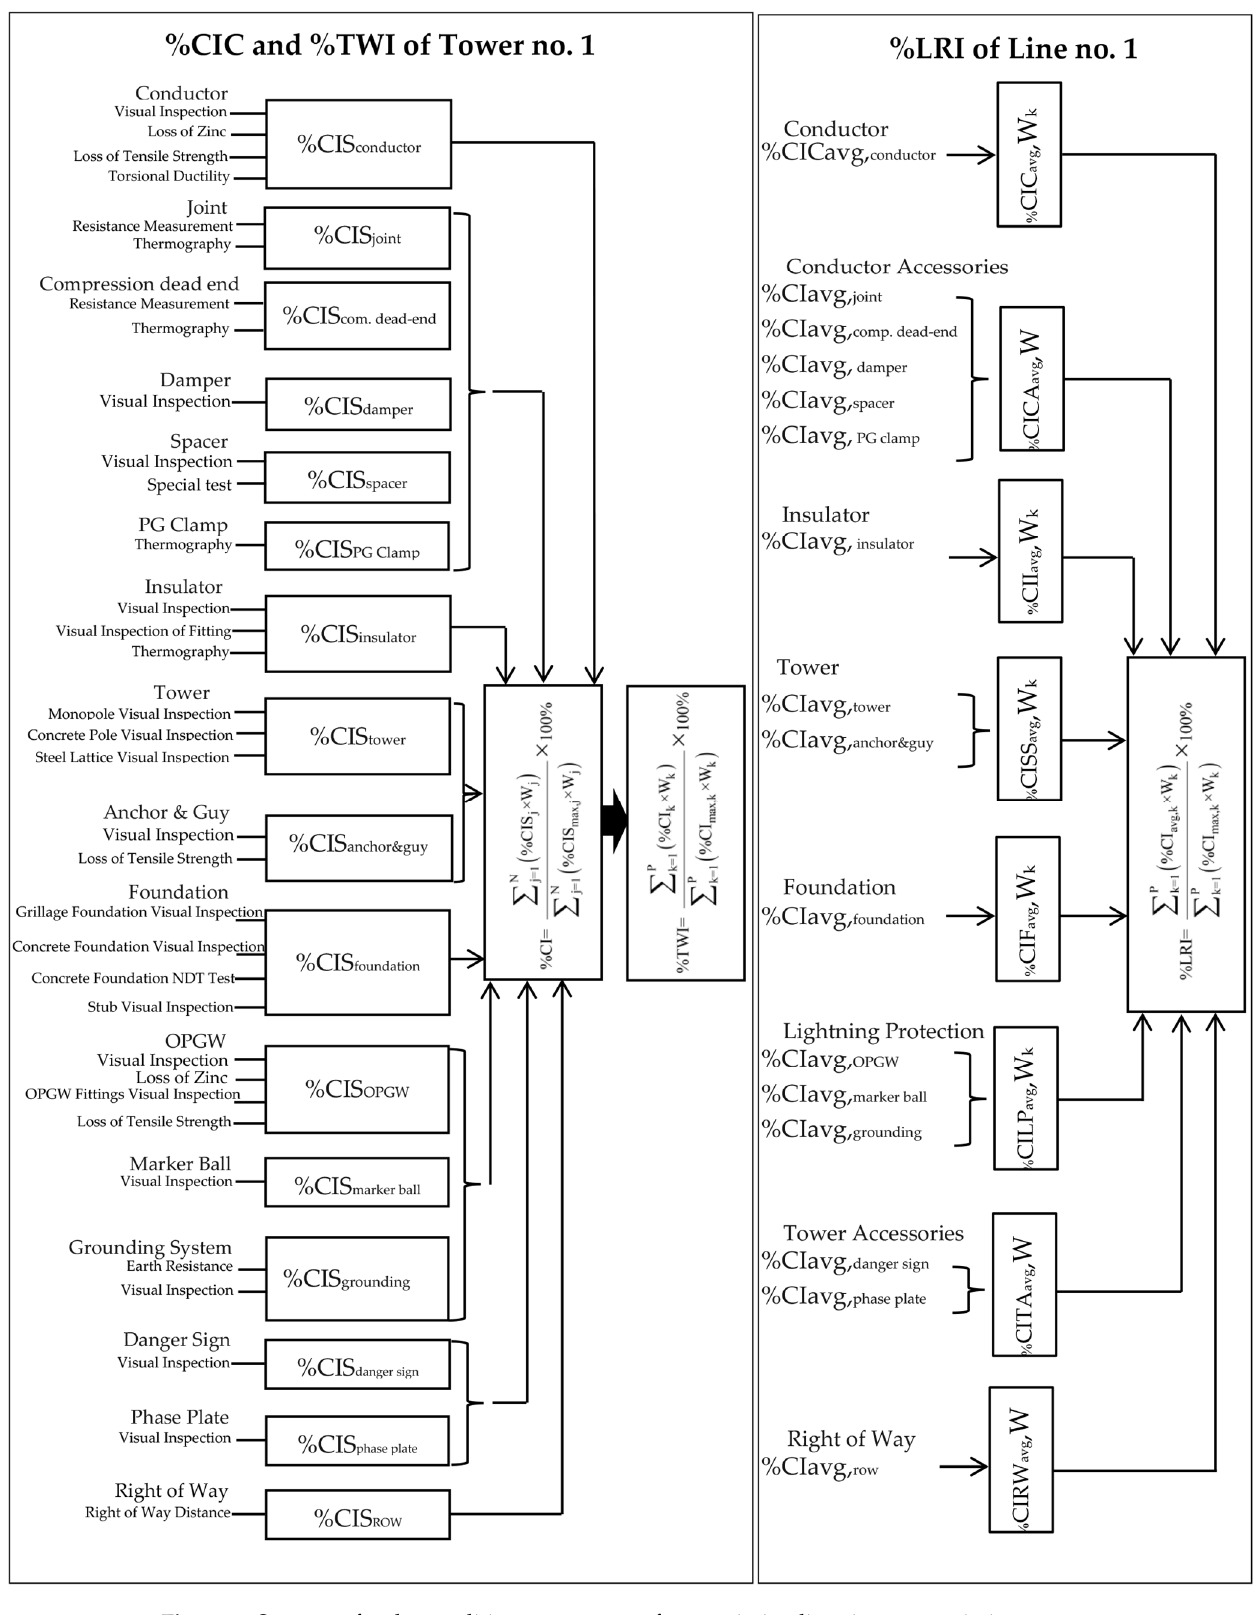
Figure 3. Structure for the condition assessment of transmission lines in a transmission system. Firstly, the WSM method is used to calculate the percentage condition index of the sub-component (%CIS), as written in Equation